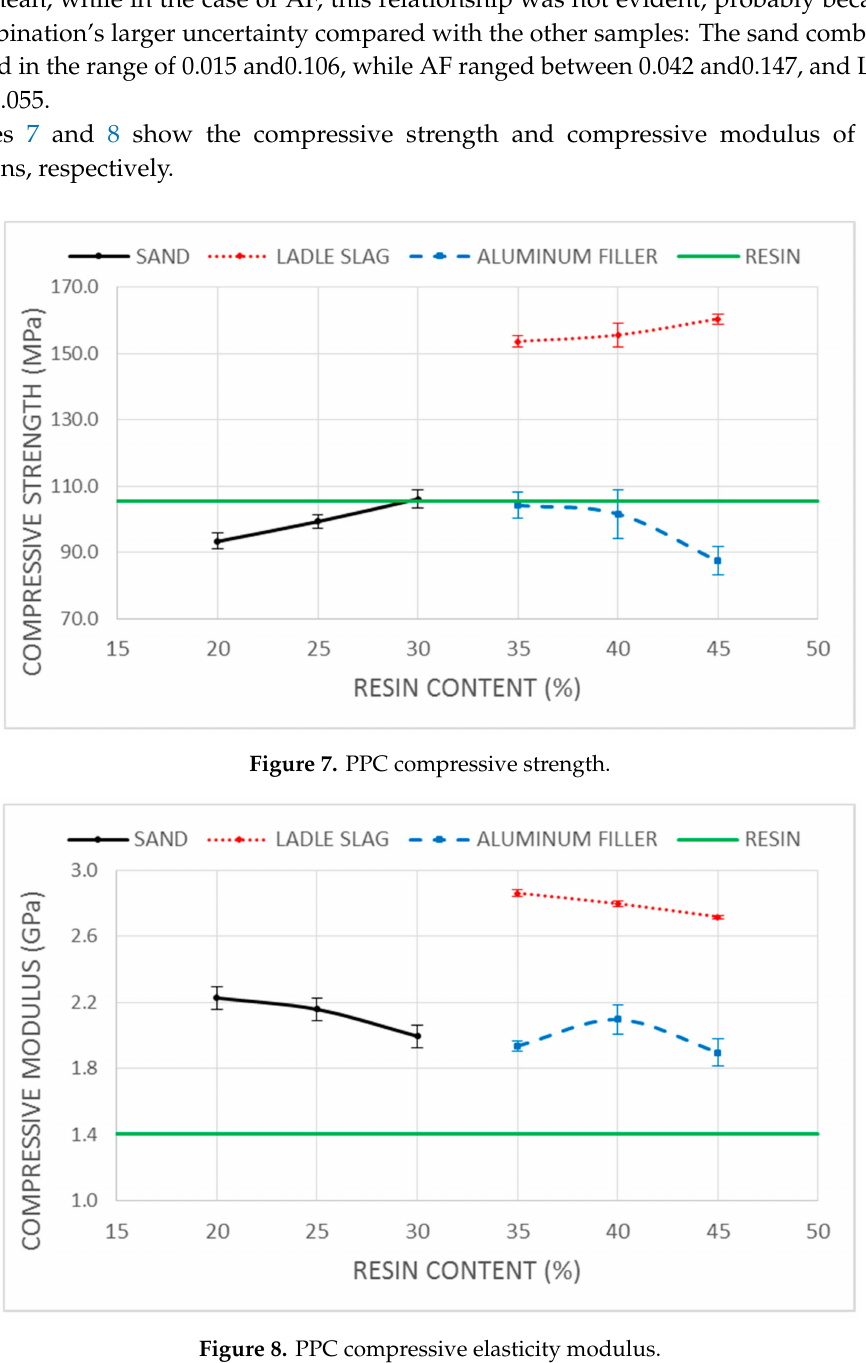
Figure 8. PPC compressive elasticity